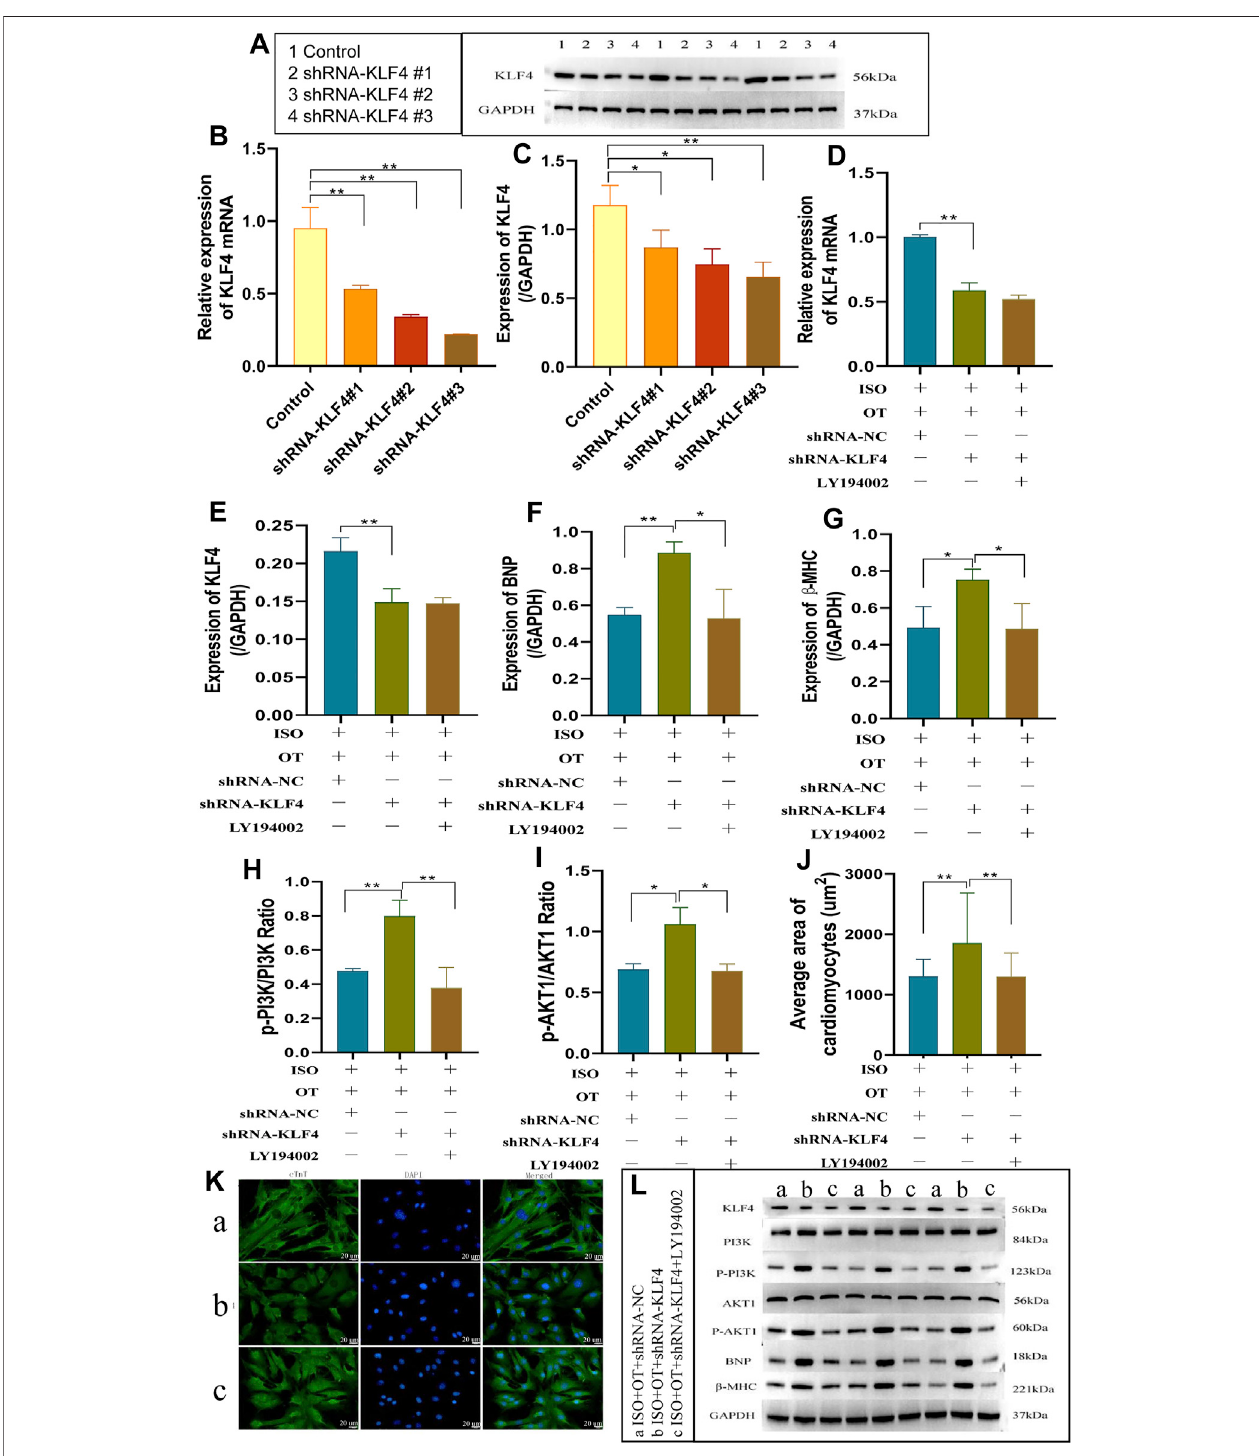
FIGURE9| knock-downofKLF4bluntedanti-hypertrophiceffectsofoxytocinviaPI3K/AKTpathway. (A – C) DetectionofrelativeshRNA-KLF4interferenceeffects. The changes in KLF4 mRNA and protein levels were detected by qRT-PCR and Western blotting after transfection of shRNA-KLF4 #1, shRNA-KLF4 #2, shRNA-KLF4 #3 in primary cardiomyocytes. (D) Expression of KLF4 mRNA was determined by qRT-PCR. (E) Expression of KLF4 protein was measured by Western blot analysis. (F,G) Expressions of BNP, β -MHC proteins were measured by Western blot analysis. (H) p-PI3K/PI3K ratio. (I) p-AKT1/AKT1 ratio. (J) Statistical results of measurement of cell surface areas. (K) Cardiomyocyte surface areas were measured by immuno fl uorescent staining. Scale bars represent 20 µm. Images were captured at × 400 magni fi cation. (L) Western blot images of KLF4, PI3K, p-PI3K, AKT1, p-AKT1, BNP, β -MHC and GAPDH levels. (a) ISO+OT+shRNA-NC group. (b) ISO+OT+shRNA-KLF4 group. (c) ISO+OT+shRNA-KLF4+LY194002 group. Data are shown as the mean ± sd of three independent experiments. *, p < 0.05; **, p < 0.01.